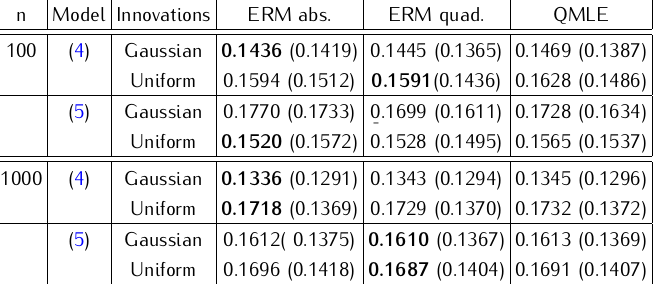
Table 3. Performances of the ERM estimators and ARMA, on the simulations. The first row “ERM abs.” is for the ERM estimator with absolute loss, the second row “ERM quad.” for the ERM with quadratic loss. The standard deviations are given in